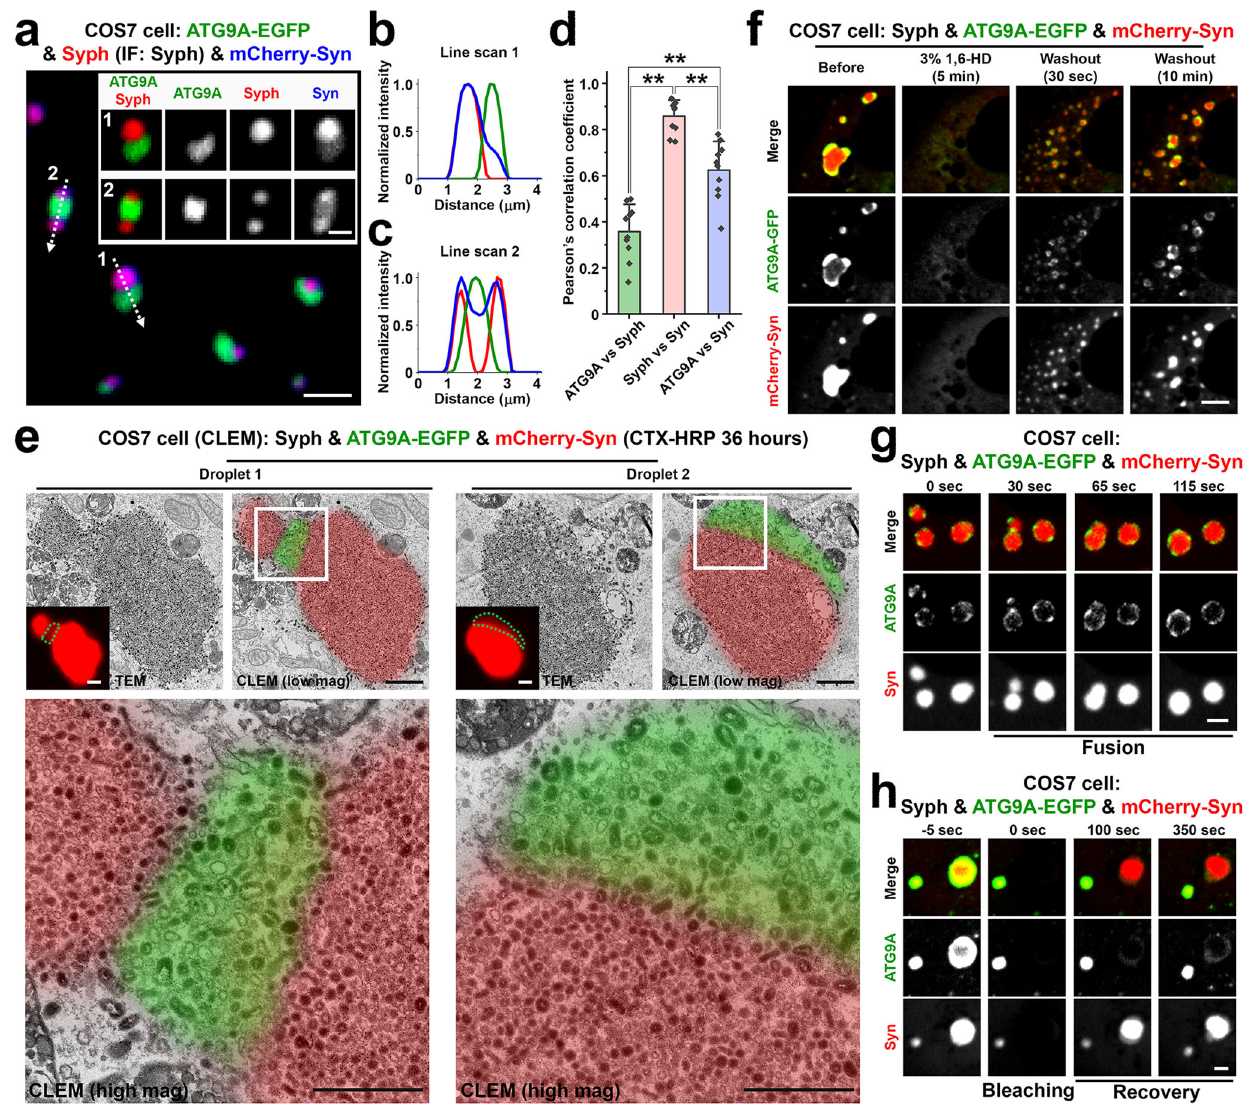
Fig. 4 | Synaptophysin and ATG9A segregate in distinct vesicle clusters within the synapsin phase. COS7 cells were triple co-transfected with synaptophysin (untagged), ATG9A-EGFP and mCherry-synapsin. a – c Representative confocal image ( a ), and corresponding line-scan analysis of the droplets ( b , c ) showing that synapsin phases include two distinct subphases containing synaptophysin and ATG9A-EGFP, respectively. Synaptophysin was visualized by immuno fl uorescence. The intensity of the mCherry-synapsin fl uorescence is more intense on the synap- tophysin phase, as quanti fi ed in d . d The colocalization of the pairs of proteins indicatedwascalculatedbyPearson ’ scoef fi cients.Valuesaremeans±SD.** p <0.01 by one-way ANOVA with Tukey ’ s HSD post hoc test (droplets in 10 different cells were analyzed). e Synaptophysin, ATG9A-EGFP and mCherry-synapsin co-